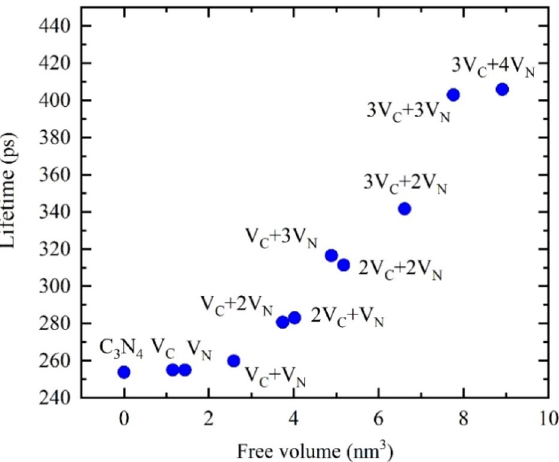
Figure 13. Calculated positron lifetimes for perfect C 3 N 4 lattice (labelled C 3 N 4 ) and for different types of point defects: carbon vacancies (V C ), nitrogen vacancies (V N ) and their complexes (nV C + mV N